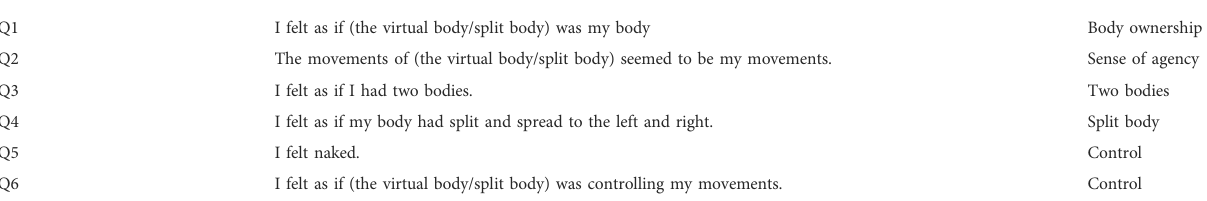
TABLE 1 Questionnaire.